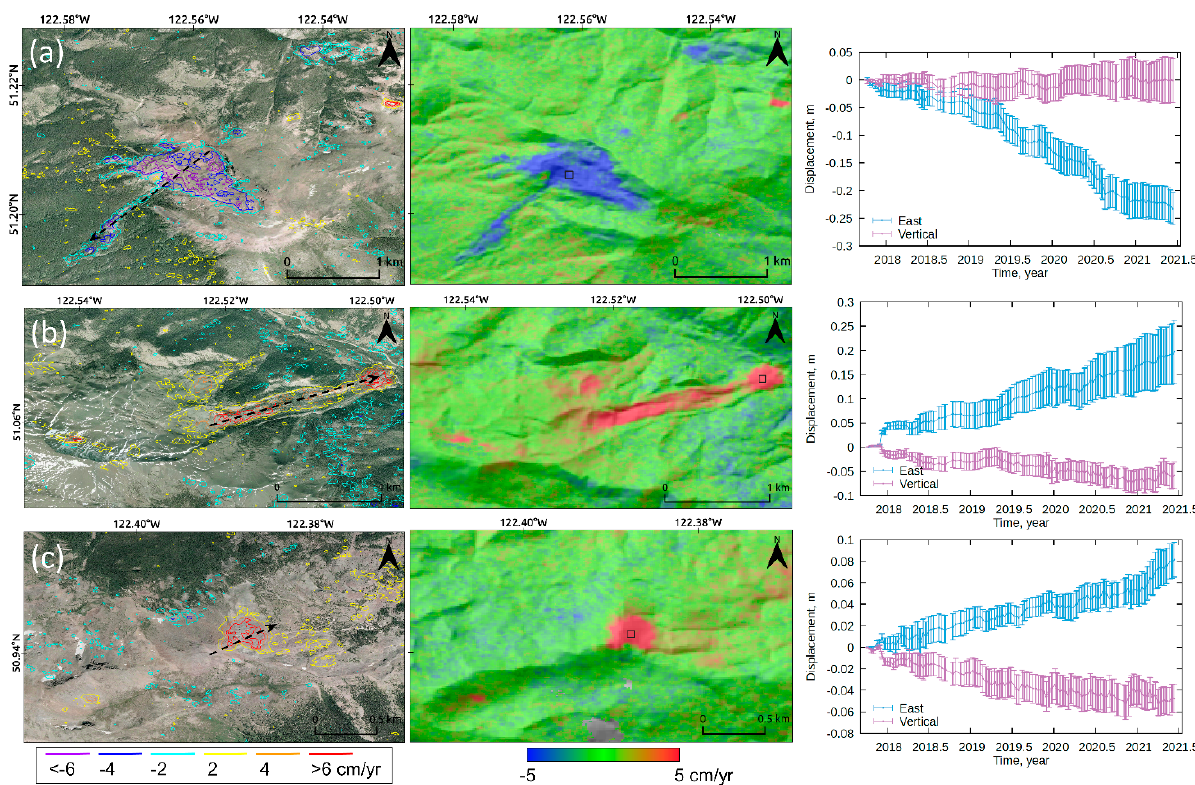
Figure 5. Close-ups of Sites 4–6 ( a – c , respectively) of Google Earth imagery ( left ) and the Sentinel-1 east–west movement map overlaid on the hillshade DEM ( middle ) with Sentinel-1 2D time-series plots ( right ; cumulative east–west (blue) and vertical (purple) movements extracted from 5-by-5 pixels marked in black squares in the middle panels). The color-coded contours and dashed black arrows in the left panels represent the east–west movement rates estimated by Sentinel-1 and the direction of earth flows, respectively. The error bars in the time-series plots represent the standard deviations of the 5-by-5 pixel measurements. Figure 5a represents the documented earthflow at Red Mountain and Figure 5b represents the largest documented earthflow at Yalakom River [32].